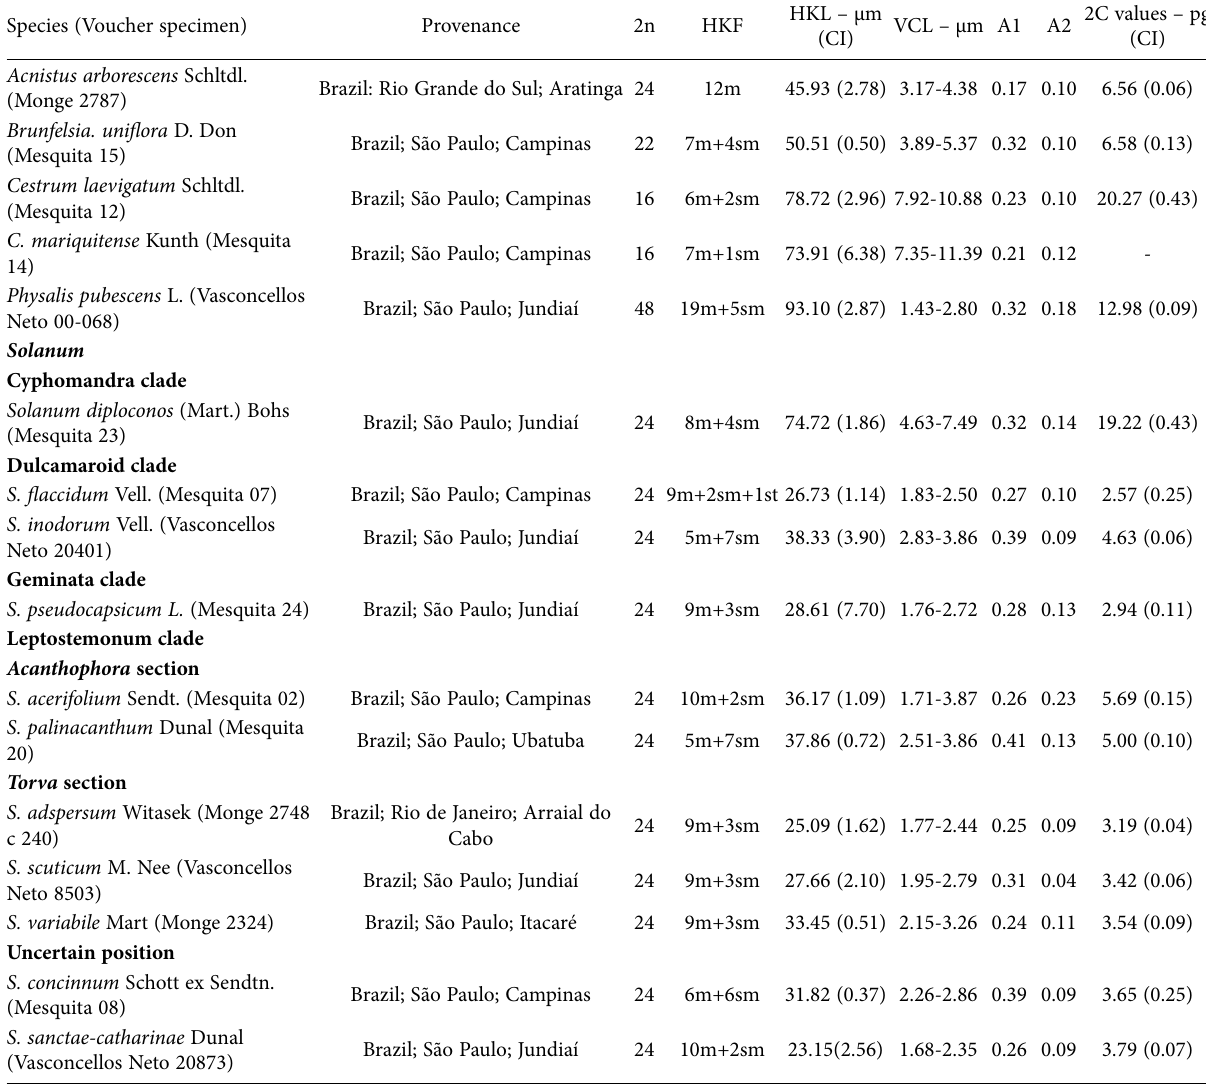
Table 1. Cytogenetics data of Solanaceae species: Species and voucher specimen; provenance of materials; chromosome number, haploid karyotype formula (HKF), median haploid karyotype length (HKL), variation in chromosome length (VCL); symmetry indices A1 and A2; median DNA content (2C